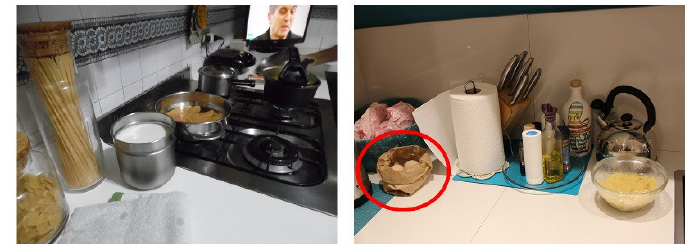
Figure 4. Raw milk and eggs left at room